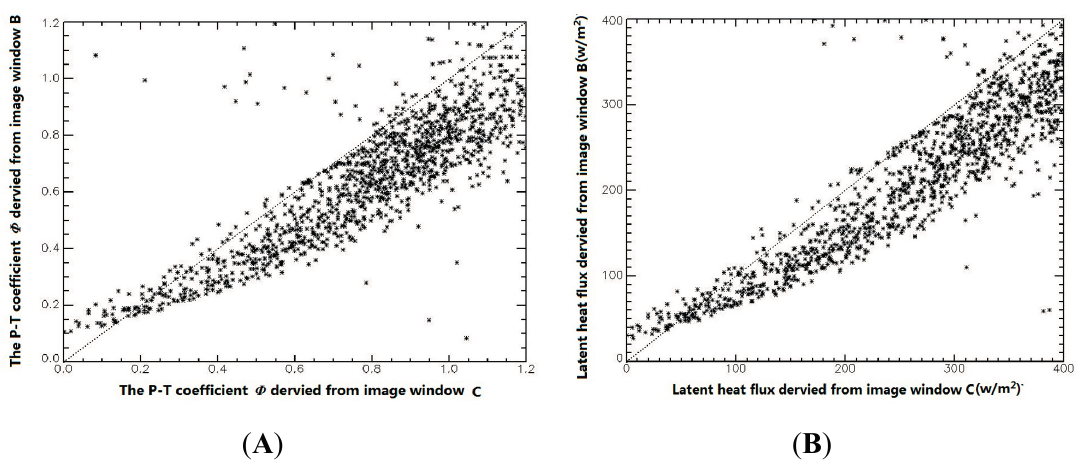
Figure 5. Comparison of estimated values for target area (window C) using LST-Fc feature space constructed from windows B and C respectively: ( A ) coefficient φ ; and ( B ) latent heat